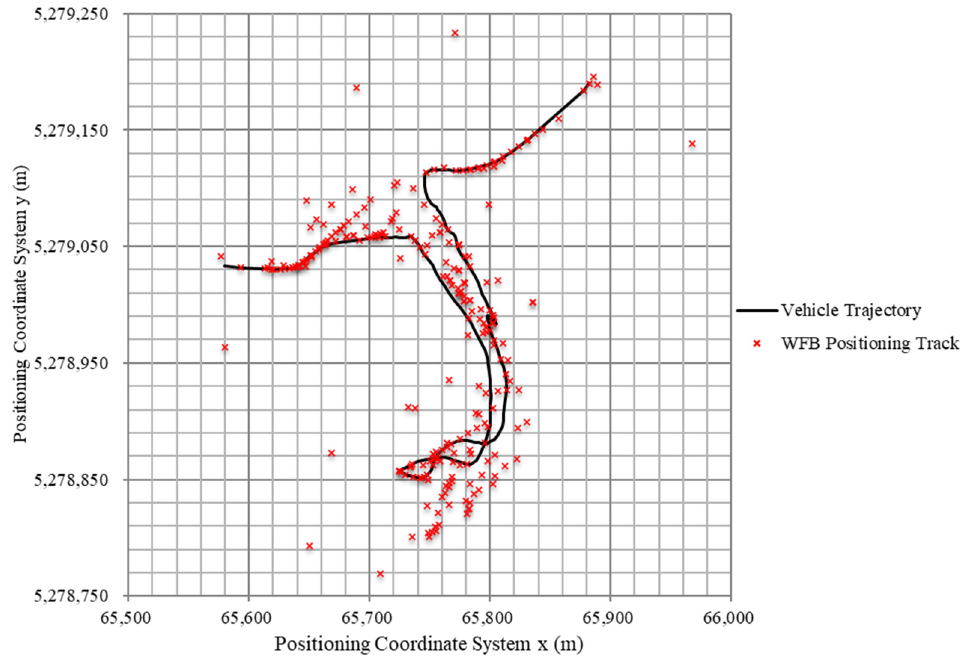
Figure 7. WFB fusion method trajectory.